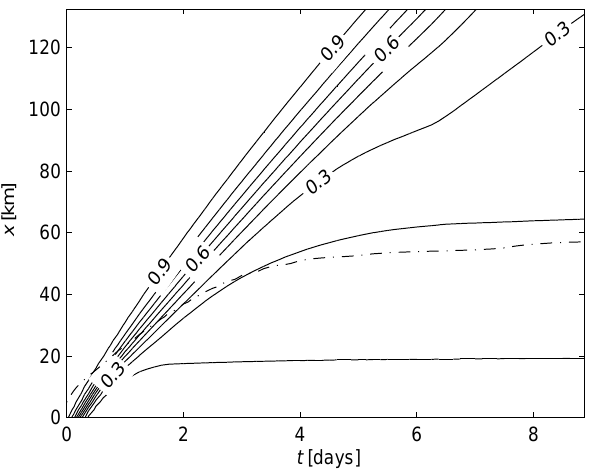
Fig. 13. The polynya size ( A p ) after eight days as a function of wind speed ( | v a | ). The size is calculated as the sum of the size of all model points where A<